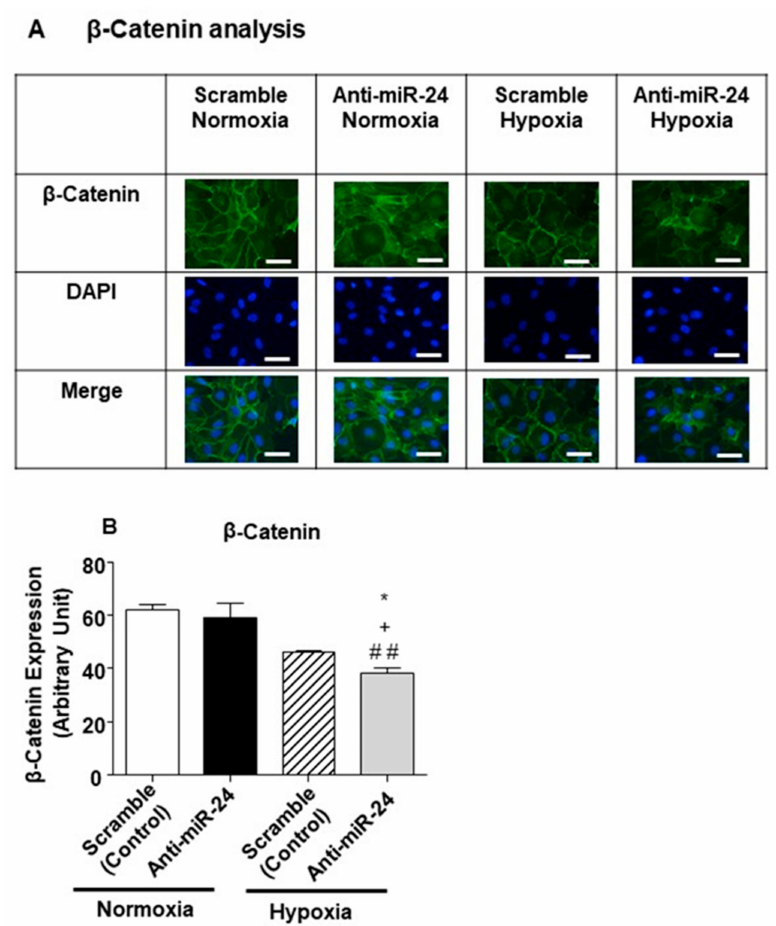
Figure 8. β -catenin modulation in in vitro model of hypoxia. ( A ) The panel shows representative pictures of β -catenin staining in HUVECs treated with miR-24-3p inhibitor and exposed to hypoxia (1% O 2 ) or kept under standard culture conditions for 48 h. Scale bars corresponds to 50 um ( B ) Bar graph shows the quantification of the staining, where the black bar represents HUVECs treated with miR-24-3p inhibitor, and the white bar represents HUVECs treated with scramble (transfection control). Adhesion assay was performed in quintuplicate and repeated two times; β -catenin staining was performed in triplicate and repeated three times. Values are means ± SEM. * p < 0,05 vs. scramble hypoxia, + p < 0.05 vs. anti-miR-24-3p in standard culture conditions; ## p < 0.01 vs. scramble in standard culture